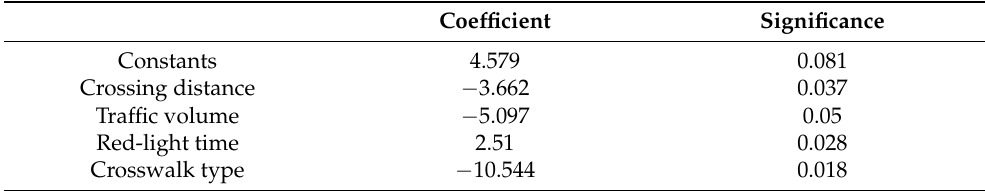
Table 3. Geographical risk model coefficients and